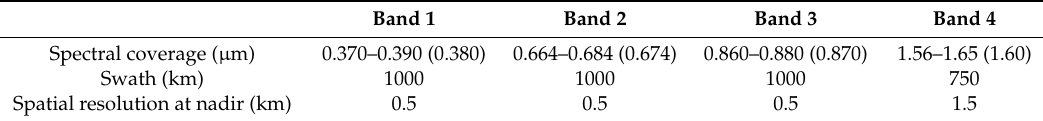
Table 1. Characteristics of GOSAT TANSO-CAI channels used in the aerosol